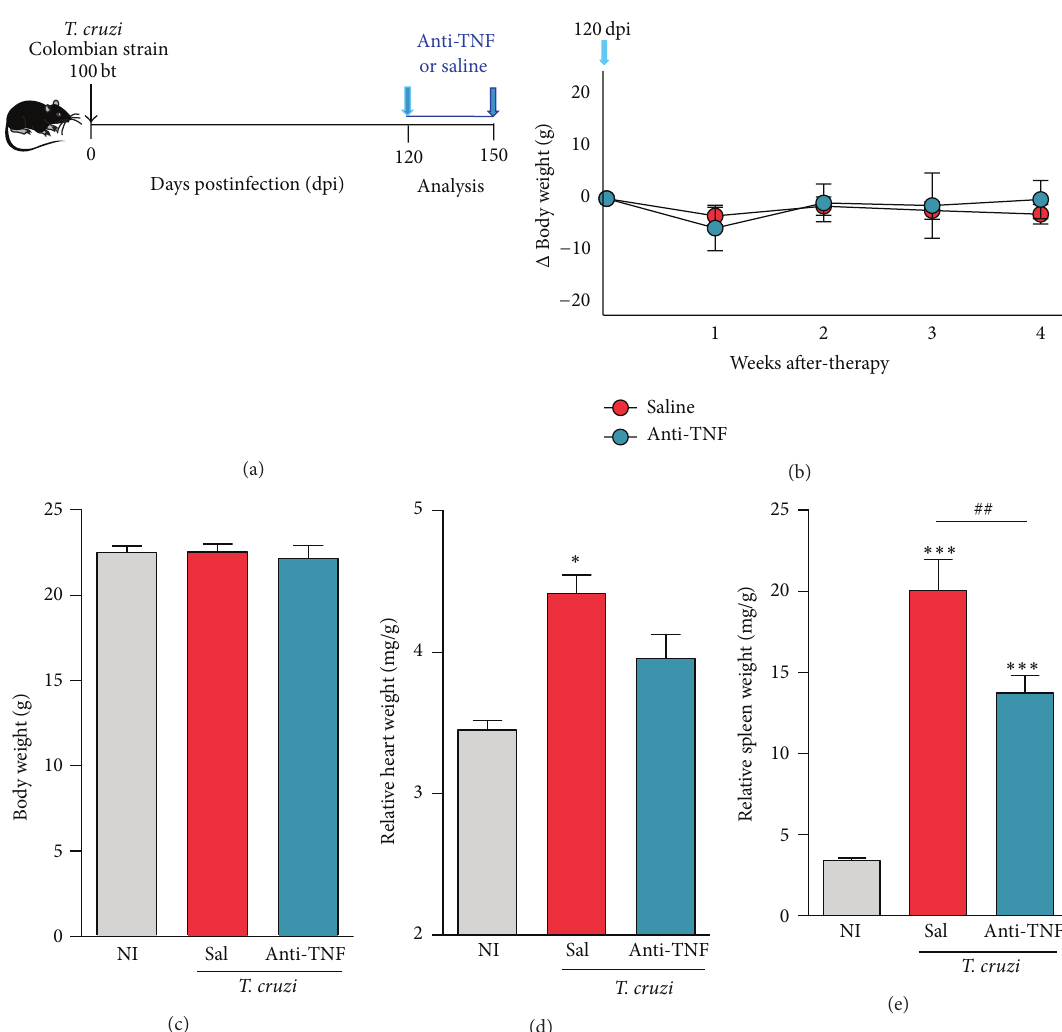
Figure 1: Anti-TNF therapy reduces Trypanosoma cruzi -induced splenomegaly in experimental model of chronic Chagas’ heart disease. (a) C57BL/6 mice were infected with 100 bt of the Colombian T. cruzi strain and received saline or anti-TNF Infliximab 48-hour intervals from 120 (light blue arrow) to 150 days postinfection (dpi); noninfected mice received saline injections; all mice were analyzed at 150 (dark blue arrow) dpi. (b) Treatments were initiated at 120 dpi (blue arrow) and variation of body weight (g) was registered weekly. (c) Body weight (g), (d) relative heart weight (mg/g), and (e) relative spleen weight (mg/g) were analyzed at 150 dpi. ∗ 𝑃 < 0.05 and ∗∗∗ 𝑃 < 0.001 , T. cruzi -infected mice(salineinjectedoranti-TNFtreated)comparedtoNIcontrols. ## 𝑃 < 0.01 ,anti-TNF-treatedcomparedtosaline-injected T.cruzi -infected mice. Bar represents the mean ± SD of the studied group (9 to 15 mice). Representative data from three independent experiments are shown.